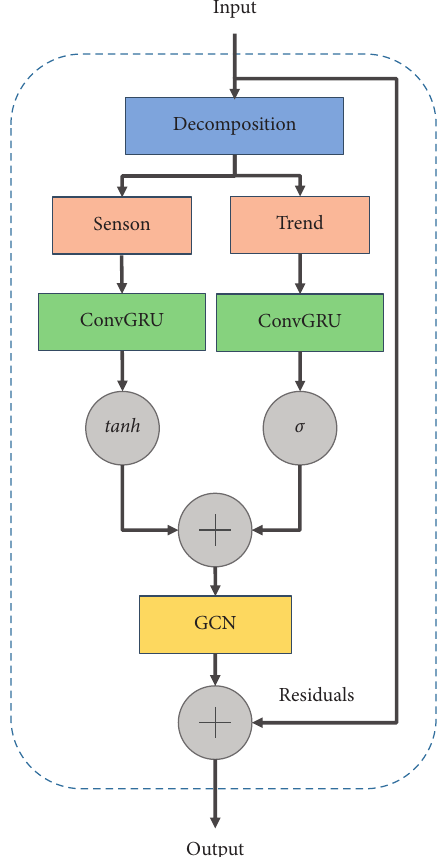
Figure 9: The structure of the gated decomposition recurrent